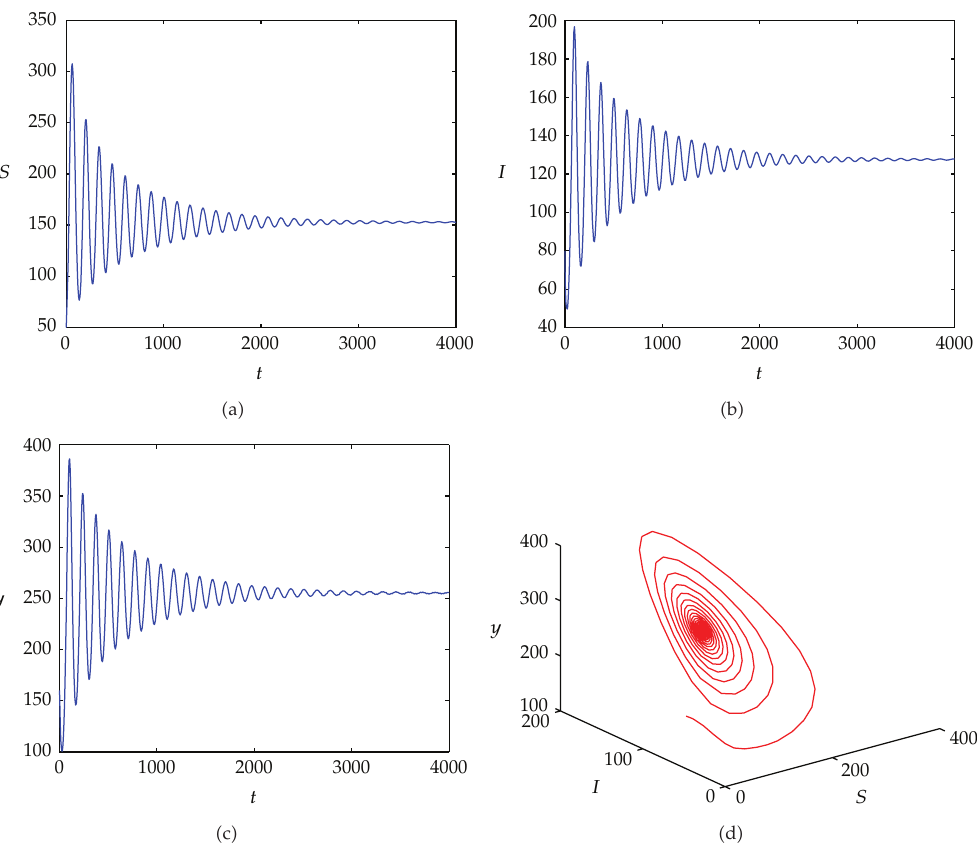
Figure 4: Time evolution of all the population for the model (cid:4) 1.4 (cid:5) with τ (cid:8) 15 . 2 and initial value (cid:4) 50 , 80 , 160 (cid:5) . (cid:4) a (cid:5) , (cid:4) b (cid:5) and (cid:4) c (cid:5) are S , I and y versus t , respectively, and (cid:4) d (cid:5) is the projected S - I - y phase